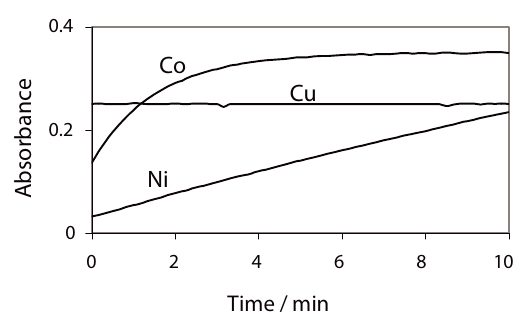
Figure 2. Kinetic profiles of complexation reaction of 0.5 μg mL -1 each of Co(II), Ni(II) and Cu(II) with PAN (1 ° —10 -3 mol L -1 ) in micellar